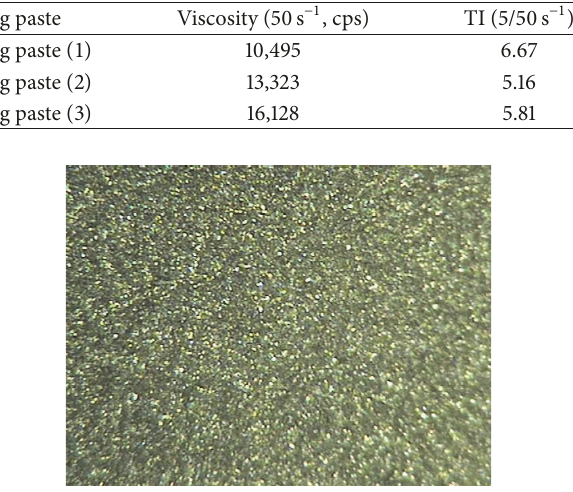
Table 2: Viscosity and thixotropic index (TI) values of silver pastes.